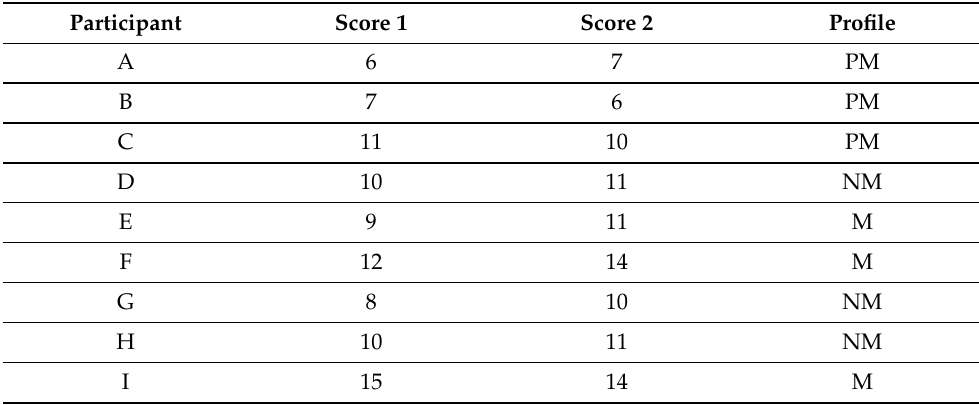
Table 2. Anonymized participants involved in the acceptance survey. The profiles are abbreviated with M (mathematical), PM (partial mathematical), and NM